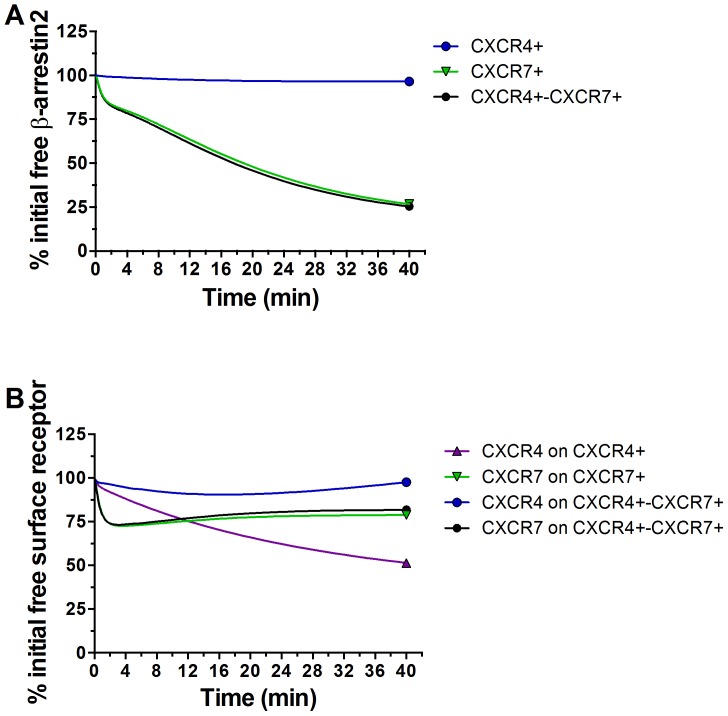
Modeling free β-arrestin 2 and free (unbound to β-arrestin 2) cell surface receptors over time.(A) Model output of the % of initial free β-arrestin 2 through 40 min in CXCR4+, CXCR7+, or CXCR4+-CXCR7+ cells treated with 1000 ng/mL CXCL12-α. (B) Model output of % of initial free (unbound to β-arrestin 2) cell surface receptors through 40 min in cells treated with 1000 ng/mL CXCL12. Legend denotes the specific receptor and cell type on which the receptor is expressed.